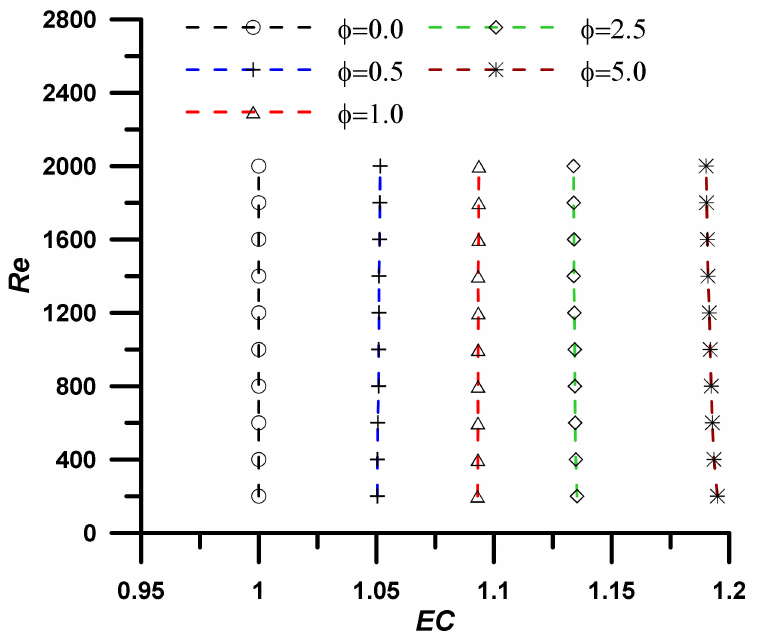
Figure 7. Evaluation performance criteria at T = 323.15 K for investigated nanoparticle concentrations.